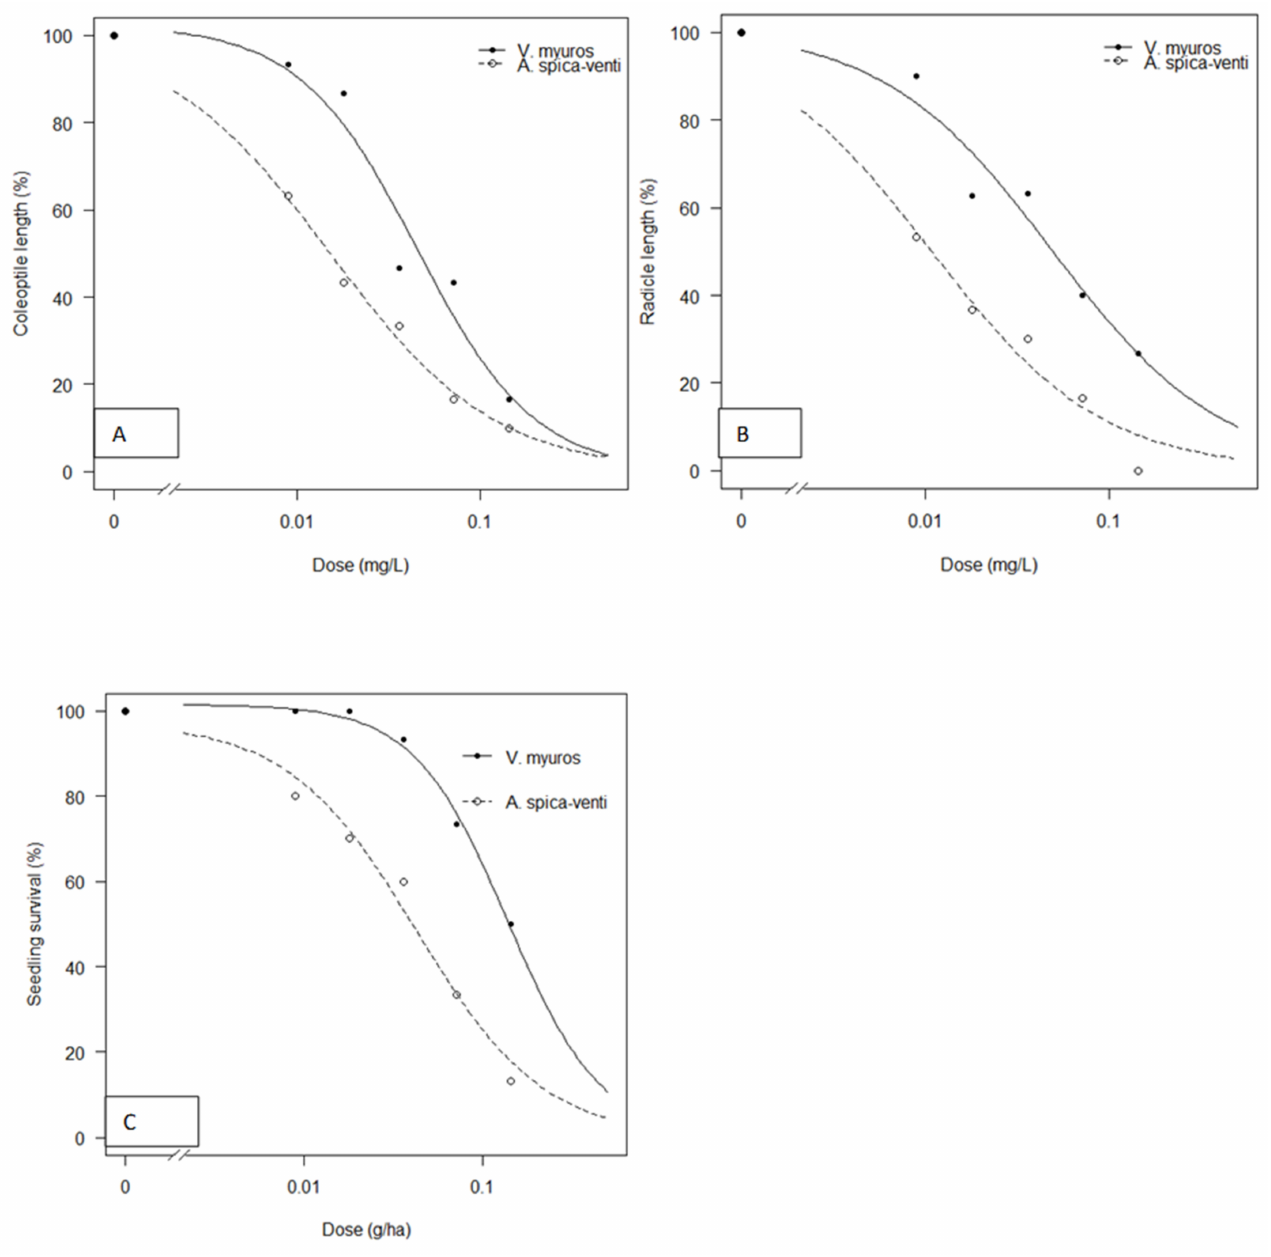
Figure 6. Dose–response of mesosulfuron-methyl + iodosulfuron-methyl on germination and coleoptile ( A ) and radicle lengths ( B ) and seedling survival ( C ) of V. myuros and A. spica-venti in agar-based